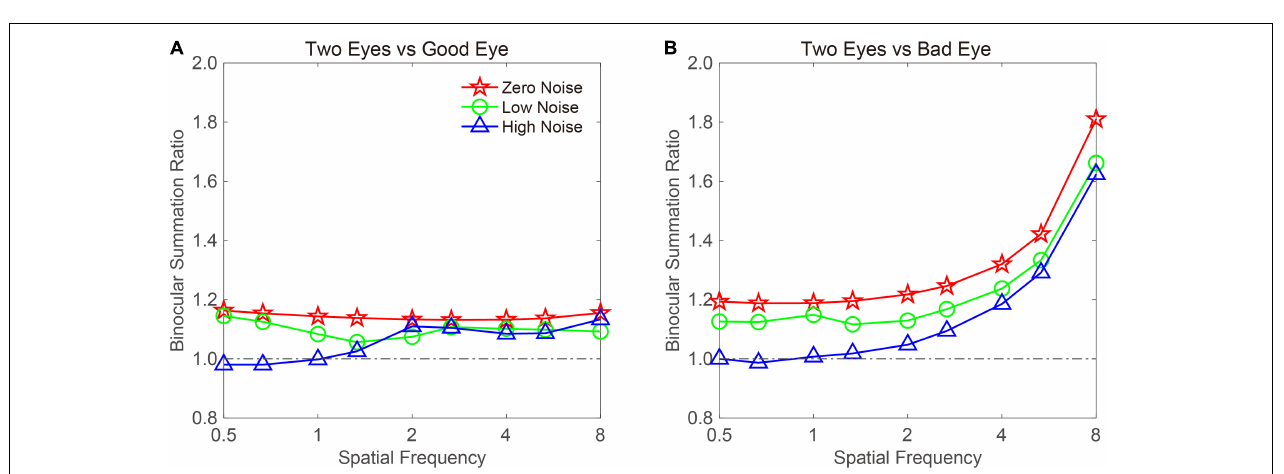
FIGURE 5 | CS-based BSRs vs. a spatial frequency curve. Data were plotted when the (A) good or (B) bad eye was considered as the standard eye, respectively. Red, green, and blue colors denote the zero-, low-, and high-noise conditions, respectively.